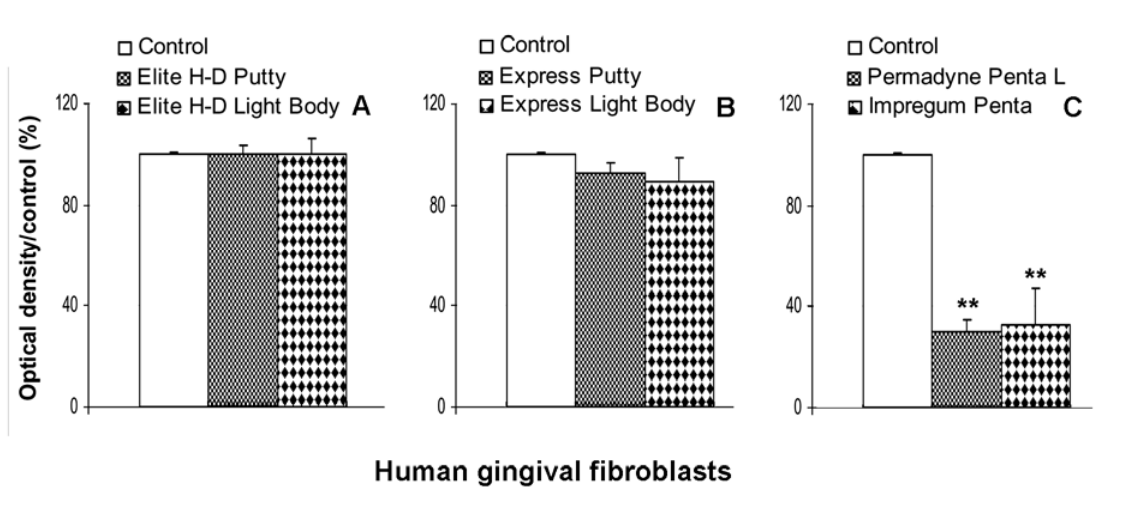
Figure 4 . Indirect effect of eluates of vinylpolysiloxane - Elite H-D Putty, Elite H-D Light Body, Figure (A), Express Putty and Express Light Body (B) - Permadyne Penta L and Impregum Penta (C) obtained after 24h of incubation on viability (evaluated by MTT tests) of human gingival fibroblasts. Data are expressed as a percentage of optical density (±SE) compared with the untreated cells. Each graph averages the results from at least